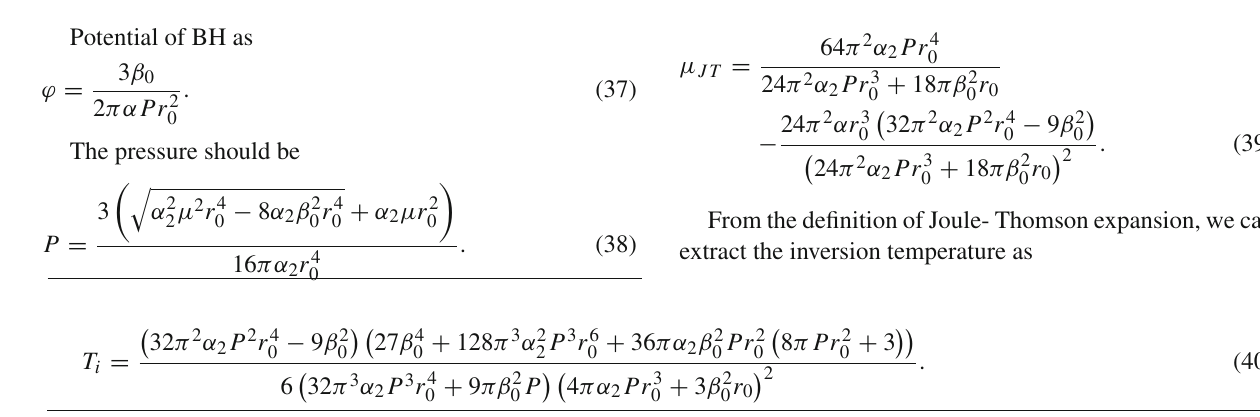
Fig. 2 Positive and negative bound points (BP) r 0 {+} , and r 0 {−} (up and down) plots along α 2 for by fixing L = − 1 , μ = 0 . 2 for differ- ent values of β 0 {left panel} and positive and negative bound points